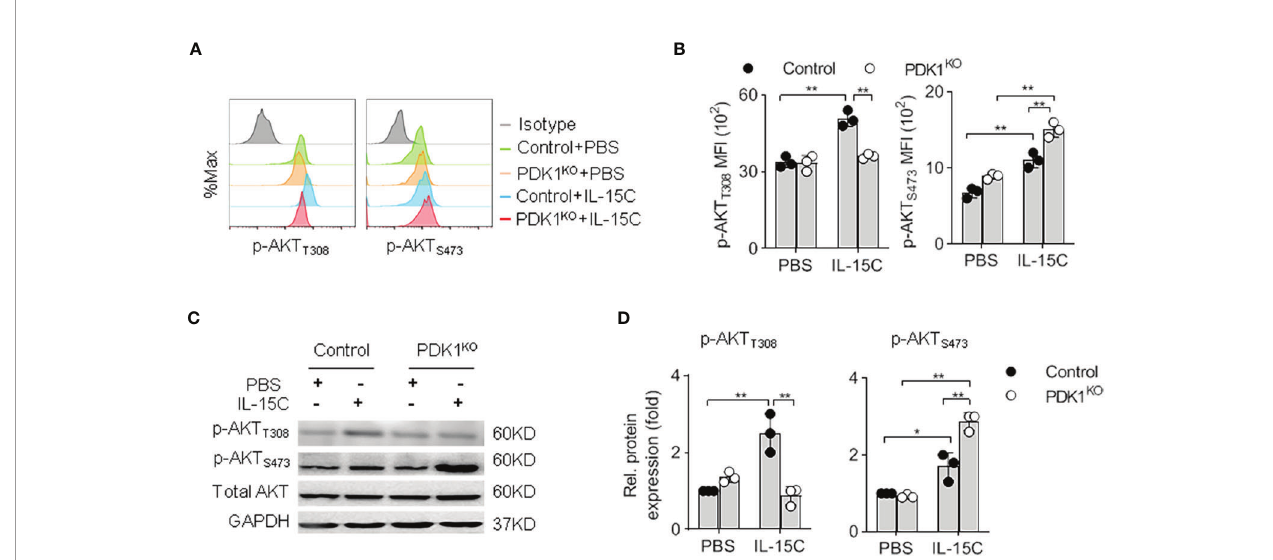
FIGURE 1 | Deletion of PDK1 abolishes PKB T308 phosphorylation but enhances PKB S473 phosphorylation in NK cells. (A, B) The expression levels of AKT phosphorylated at T308 (p-AKT T308 ) and S473 (p-AKT S473 ) in Control or PDK1-de fi cient NK cells were determined by fl ow cytometry after IL-15C stimulation. Representative overlaid histograms (A) , absolute MFI for p-AKT T308 and p-AKT S473 (B) . (C, D) The expression levels of p-AKT T308 and p-AKT S473 in Control or PDK1-de fi cient NK cell were analyzed by Western blotting (C) and densitometry (D) after IL-15C stimulation. *p < 0.05, **p <